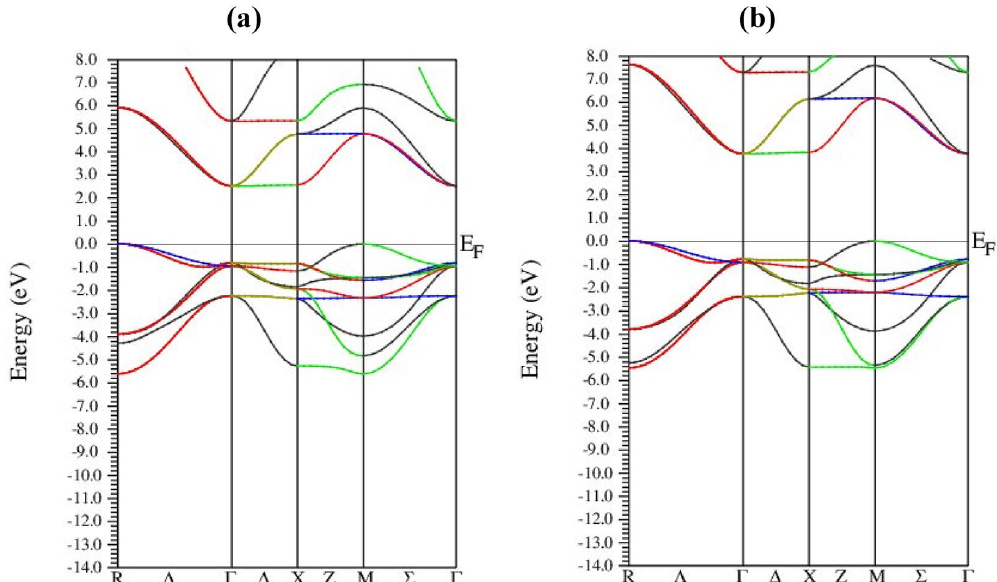
Figure 4. Band-structure diagrams for alkali (Na)-based ( a ) niobate (NaNbO 3 ) and ( b ) tantalate (NaTaO 3